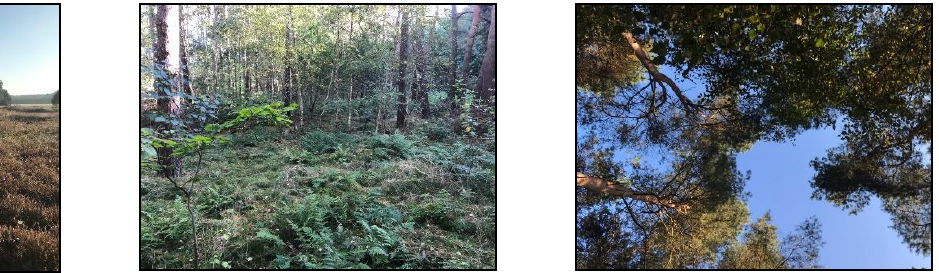
Figure 1. Spatial distribution of the 8 sites in northwest Germany where moss specimens were collected from 26 open land and canopy drip plots in 2021.